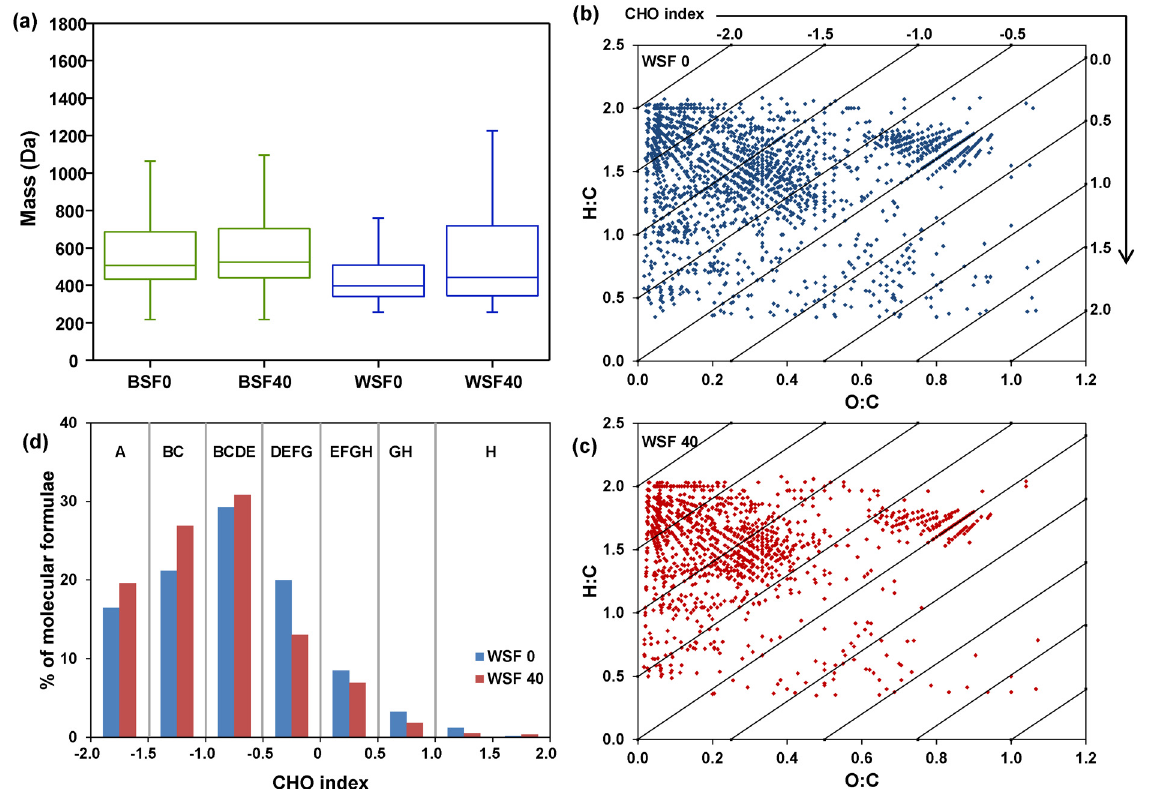
Fig 2. Molecular distribution of extracted SOM compounds from a 40-day soil warming incubation experiment. (a) Box-and-whisker plots of the mass distribution of SOM compounds, including the base-soluble fraction (BSF) at day 0 (BSF0) and day 40 (BSF40) and the water-soluble fraction (WSF) at day 0 (WSF0) and day 40 (WSF40). (b and c) van Krevelen diagram along with CHO index showing the molecular distribution of WSF SOM compounds before (b) and after (c) incubation. (d) Percentages of molecular formulae identified with CHO index values between -2 and 2 before and after soil incubation and are normalized to the total number of formulae displayed in (b) and (c). Compound classes are labeled above colored bars as follows: (A) lipids, (B) unsaturated hydrocarbons, (C) peptides, (D) aminosugars, (E) carbohydrates, (F) lignin, (G) condensed hydrocarbons, (H)